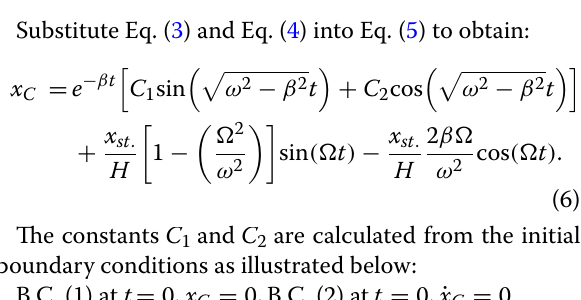
Figure 1 One degree of freedom